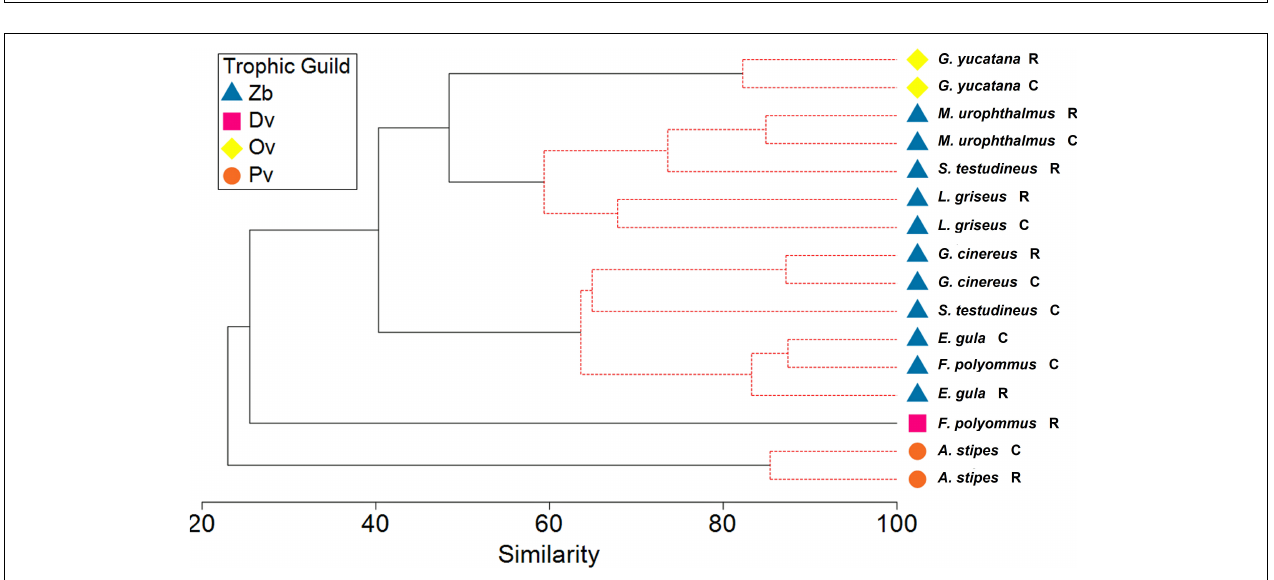
FIGURE 2 | Cluster analysis of F. polyommus showing the similarity of the preys in conserved and restored mangrove zones, and the results of the ANOSIM analysis.